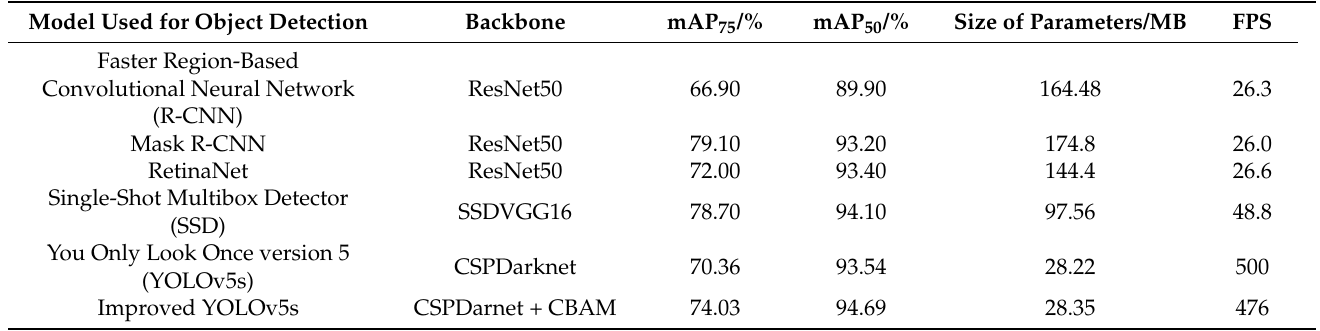
Table 4. Performance comparison of different smoke detection models.